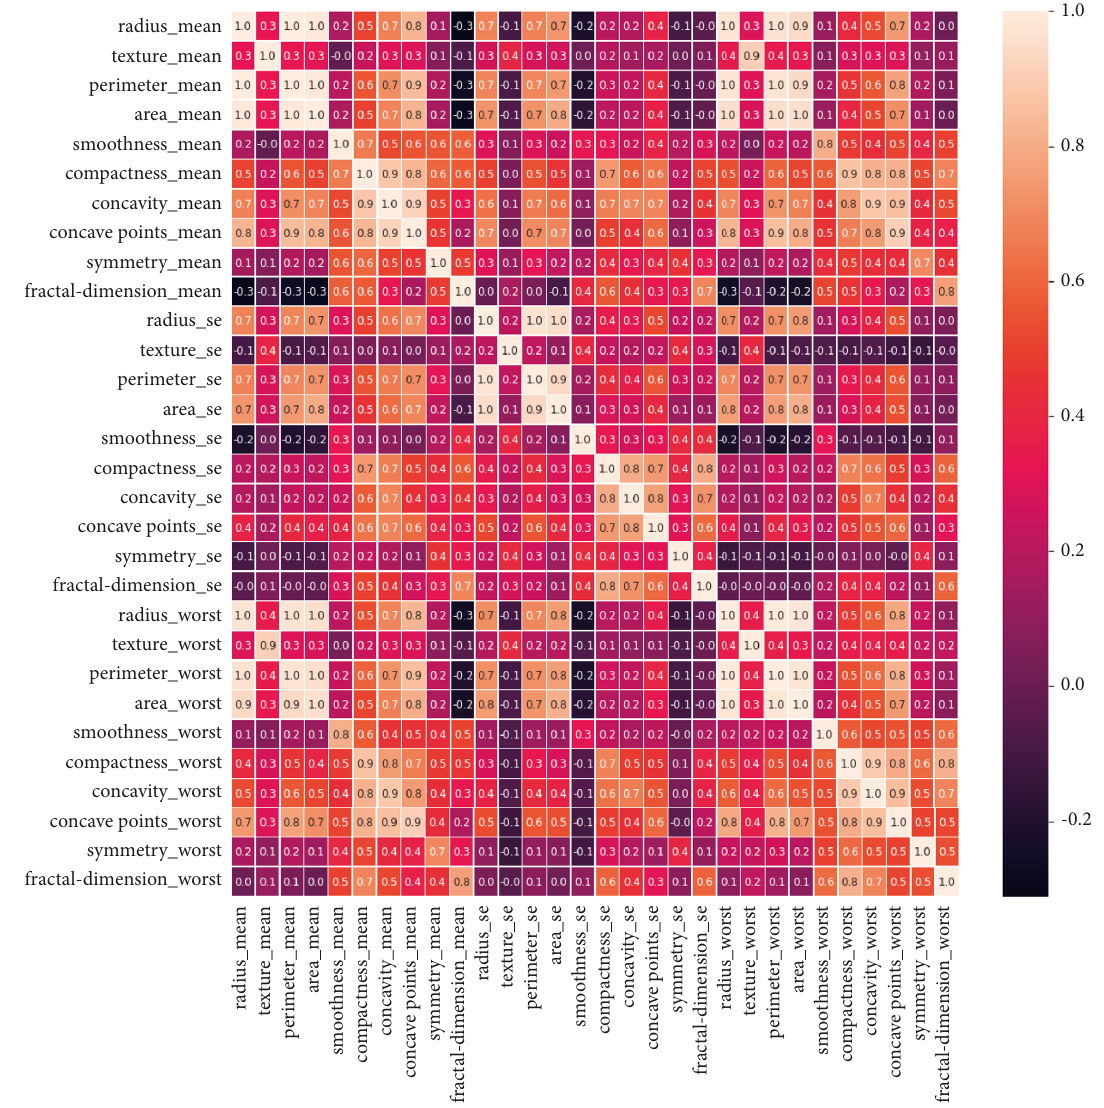
Figure 5: Correlation heat map for the breast cancer data set.